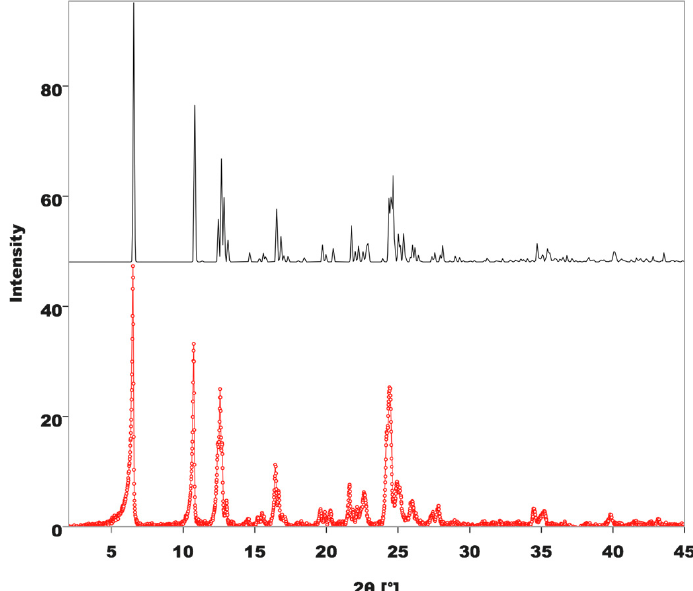
Figure 5. Comparison of the powder diffractogram of 1 · 4H 2 O (in red) with the simulation obtained from single crystal data (in black).